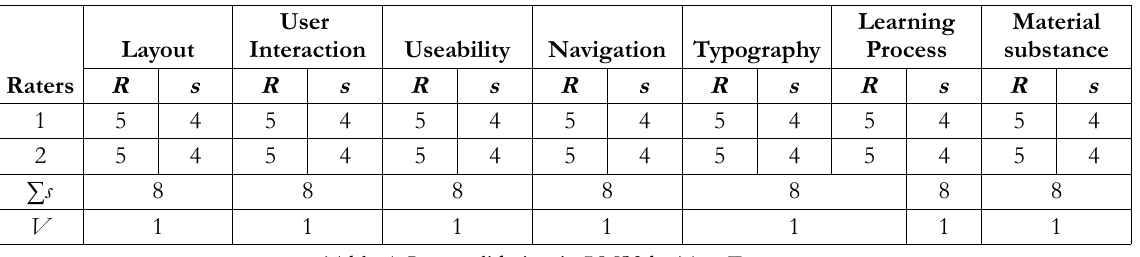
Table 4. Item validation in LMS3 by Two